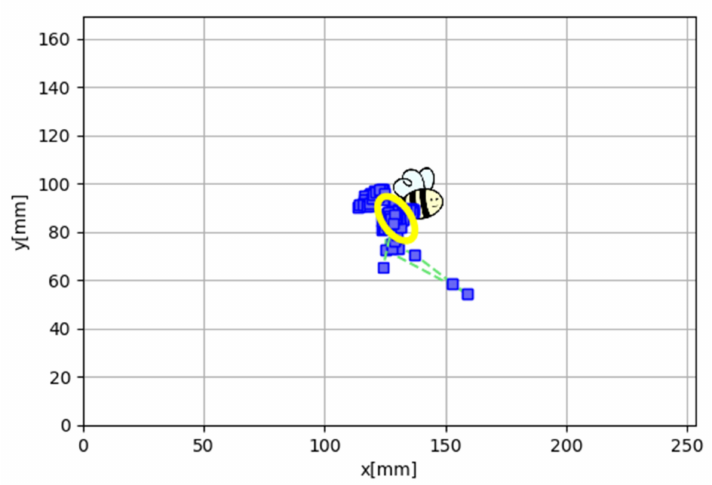
Figure 2. Representation of the fixation on visual stimulus of one study participant with the plot of the bivariate contour ellipse area